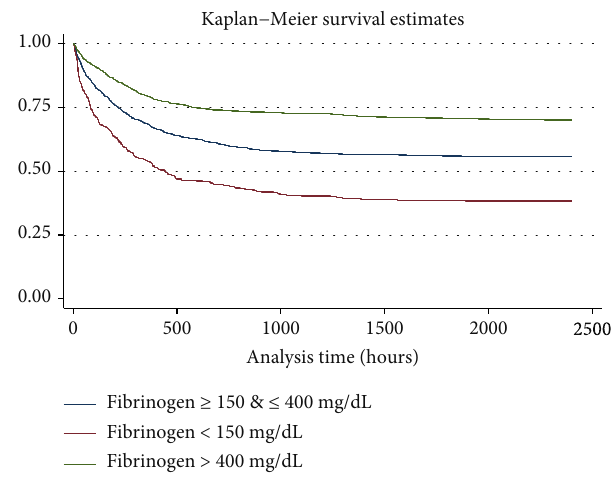
Figure 2: Kaplan-Meier survival